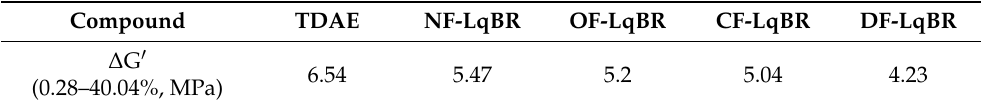
Table 6. Δ G ′ values of the compounds. Table 6. ∆ G (cid:48) values of the